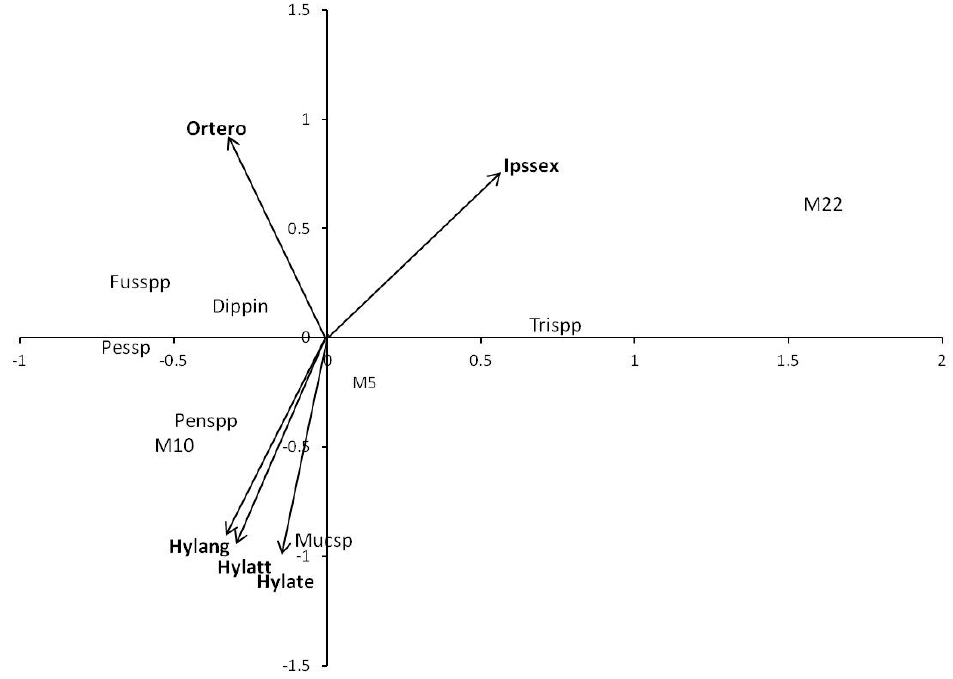
Figure 1. Non-metric multidimensional scaling (NMDS) at insect species level (Ortero = O. erosus , Ipssex = I. sexdentatus , Hylang = H. angustatus , Hylatt = H. attenuatus , Hylate = H. ater ). Fungal species (Fusspp = Fusarium spp., Dippin = D. sapinea , Trispp = Trichoderma spp., Pessp = Pestalotopsis sp., Penspp = Peniophora spp., Mucsp = Mucor sp.) correspond to those isolated from the insect galleries on Pinus radiata logs. Dissimilarity distance = Bray–Curtis.